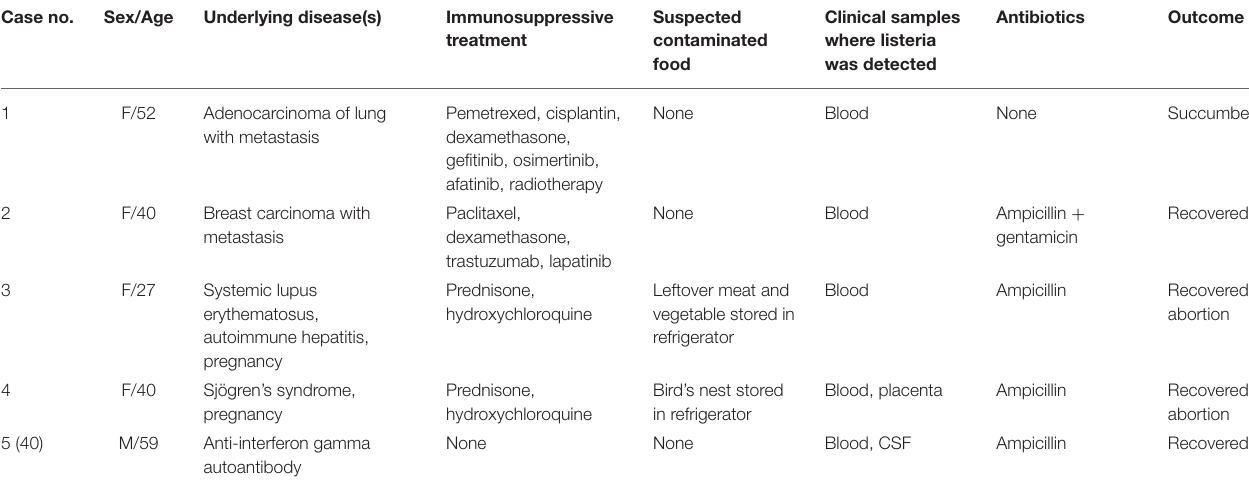
TABLE 1 | Patients with listeriosis in the present cohort. Case